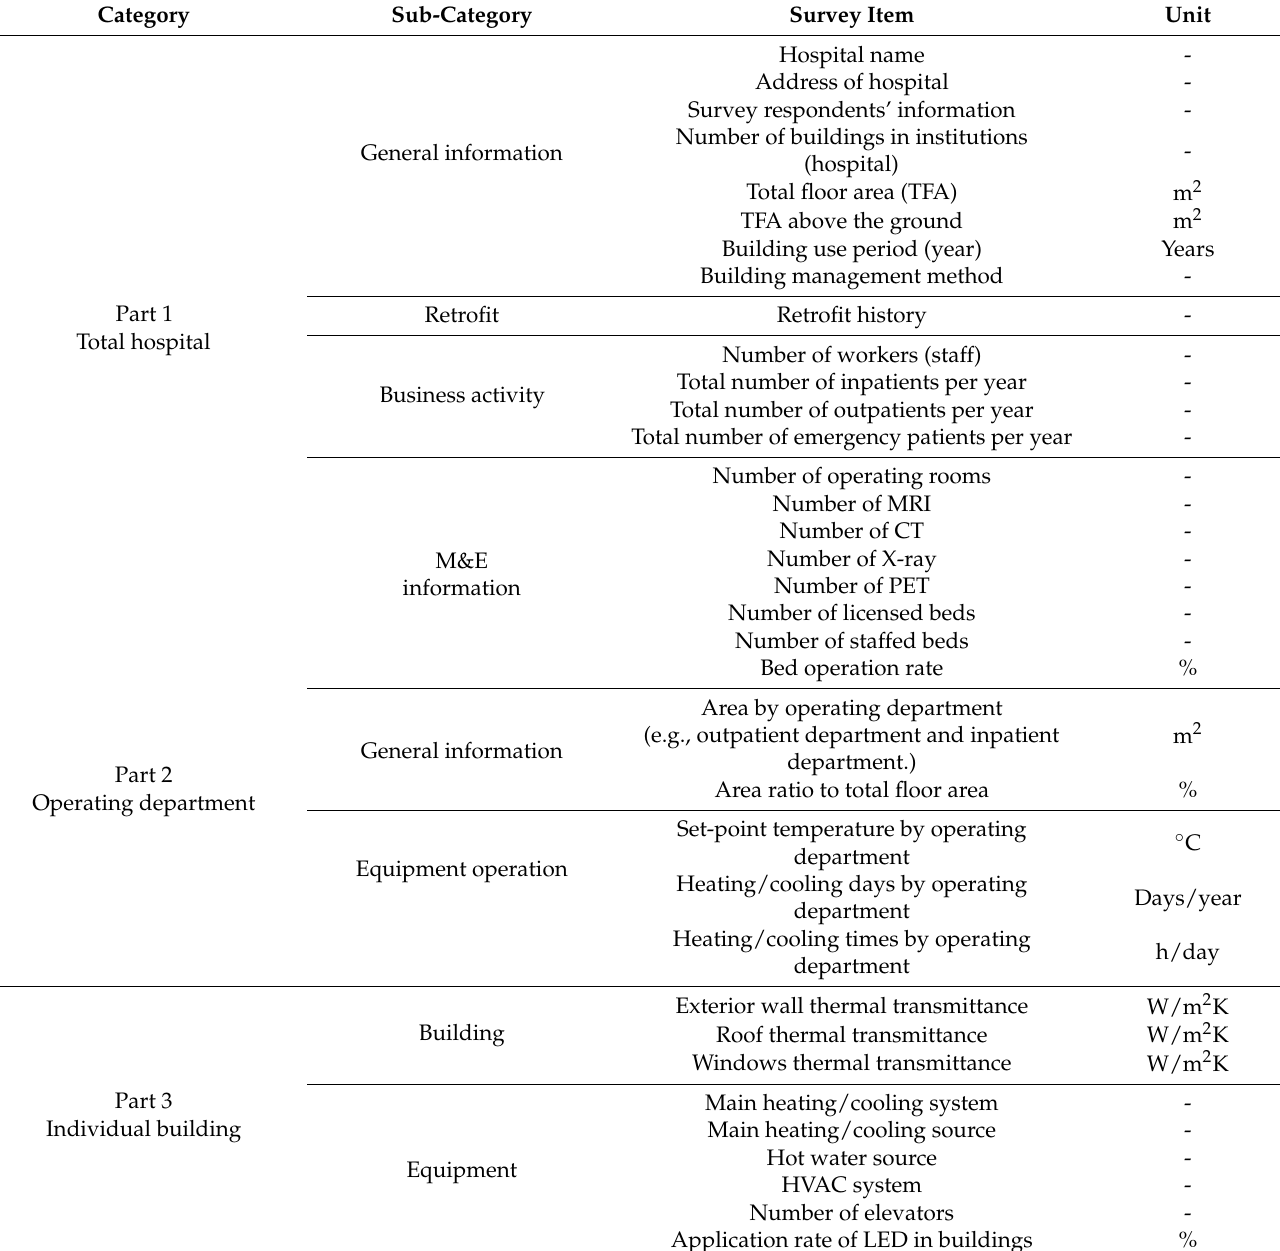
Table 5. Established survey items in this